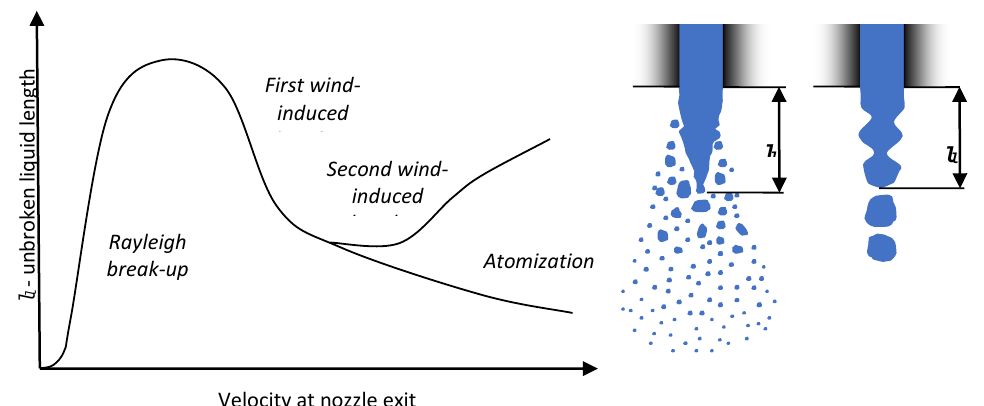
Figure 8. Unbroken liquid length of the jet versus velocity at the nozzle exit and the definition of the unbroken liquid length for different types of break-up (based on [27–29]).